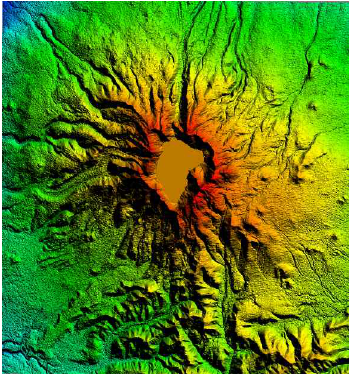
Figure 1. Mt. Baekdu area digital elevation